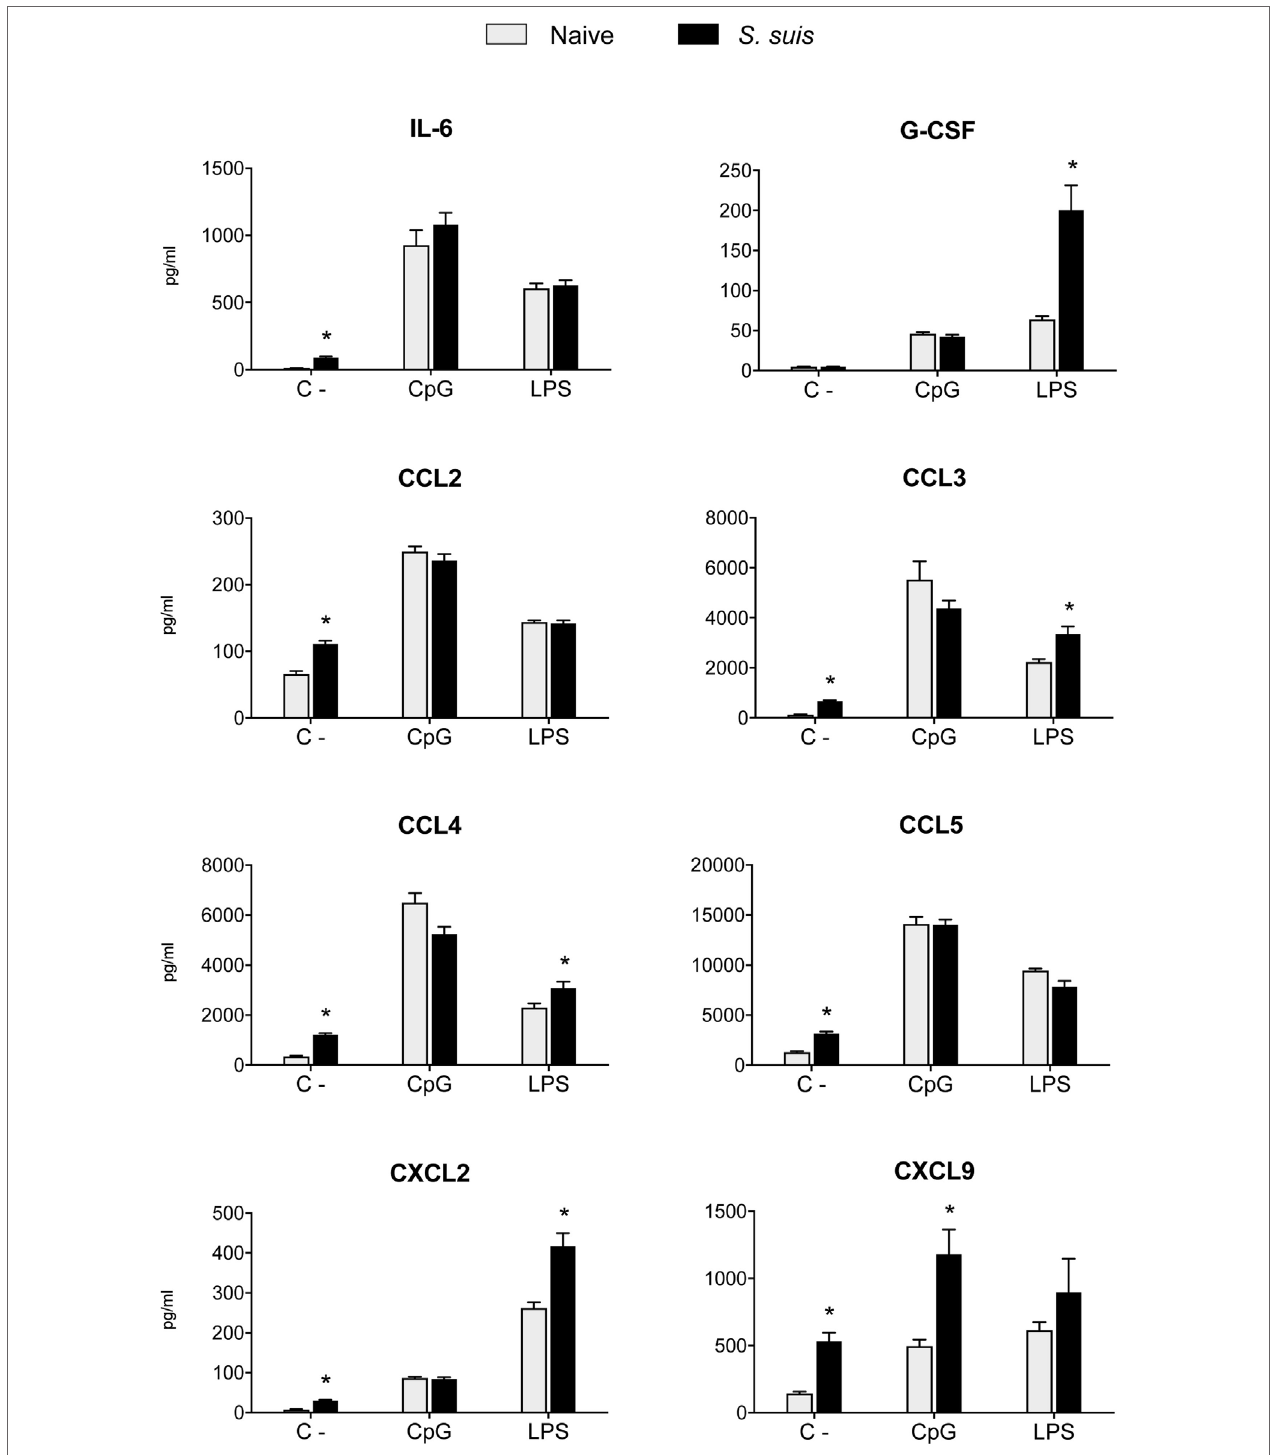
FigUre 7 | Splenic dendritic cells (DCs) maintain their secretion capacity of various cytokines and chemokines following Streptococcus suis infection. C57BL/6 mice were injected intraperitoneally with 5 × 10 7 CFU of S. suis wild-type (WT) strain P1/7. Spleens from mock-infected (naïve) and infected mice were harvested 6 h after infection ( n = 8 per group). Splenic DCs were purified by MACS positive selection. Cells were cultured for 24 h ex vivo with CpG oligodeoxynucleotides (1 µM) or LPS (1 µg/ml). Supernatants were harvested, and cytokine and chemokine levels were quantified by Luminex. Unstimulated cells served as negative controls (C − ) for basal expression. Data were collected with Bio-Plex Manager ™ software and analyzed with Bio-Plex ® MAGPIX system. Data are expressed as mean ± SEM (in pg/ml). * P < 0.05 indicates a statistically significant difference compared to naïve